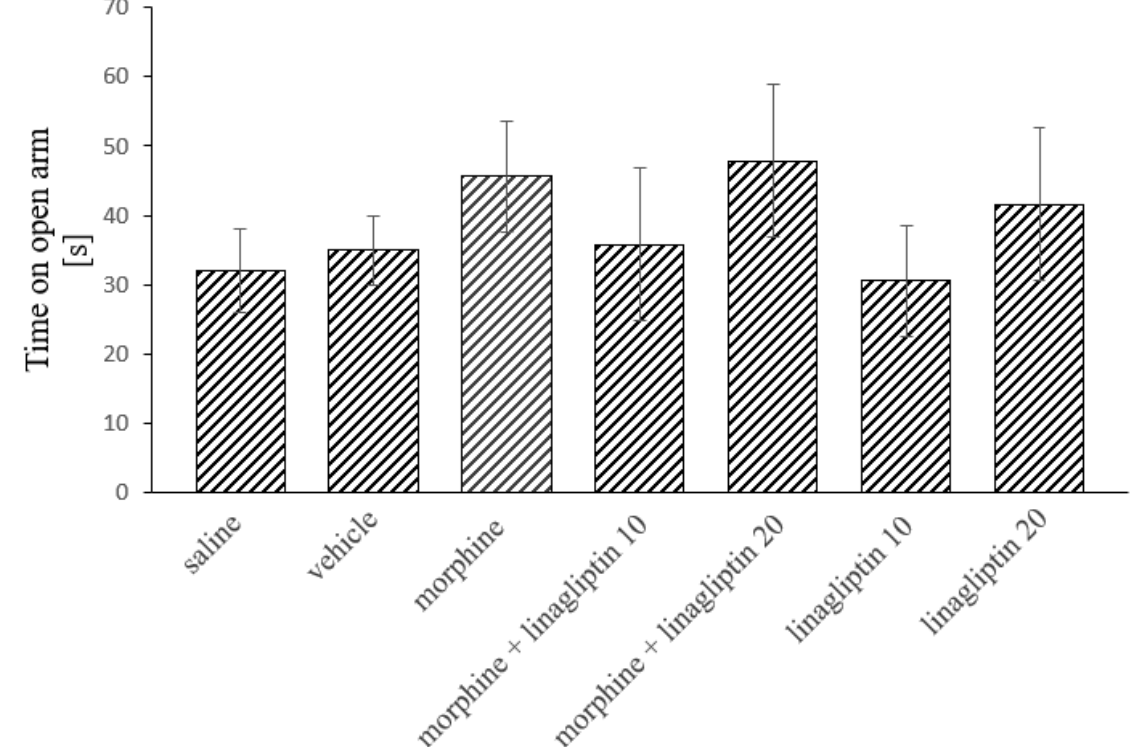
Figure 5. The influence of linagliptin (10 and 20 mg/kg, ip) administered simultaneously with morphine on anxiety behavior observed in mice, in the elevated plus maze test, during: ( A ) short- term (60 h) and ( B ) long-term (14 days) morphine withdrawal. Morphine was administered twice a day for eight consecutive days (10, 15, 20, 25, 30, 35, 40 and 50 mg/kg, ip). Linagliptin was injected once a day, 30 min prior to morphine injection, in the morning (altogether, 8 injections). The effect of linagliptin on anxiety during morphine withdrawal was observed 60 h or 14 days after the last morphine injection (short-term or long-term withdrawal of morphine, respectively). Anxiety in mice was observed as the time in which the mice spent in the open arm in the elevated plus maze test. The results are shown as the average time spent in the open arm (s) ± SEM. * p < 0.05 vs. saline/vehicle group, # p < 0.05 vs. morphine group (the Tukey’s test).